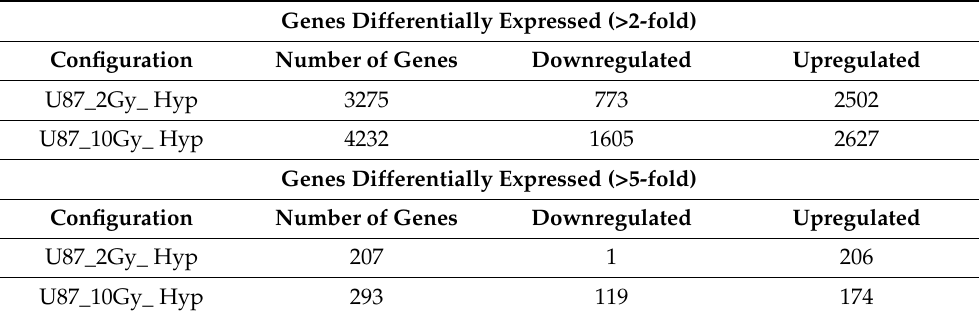
Table 1. Number of genes significantly deregulated by 2-fold or 5-fold in all the configurations assayed in this work. Genes Differentially Expressed (>2-fold) Configuration Number of Genes Downregulated Upregulated U87_2Gy_ Hyp 3275 773 2502 4232 2627 Genes Differentially Expressed (>5-fold) Configuration Number of